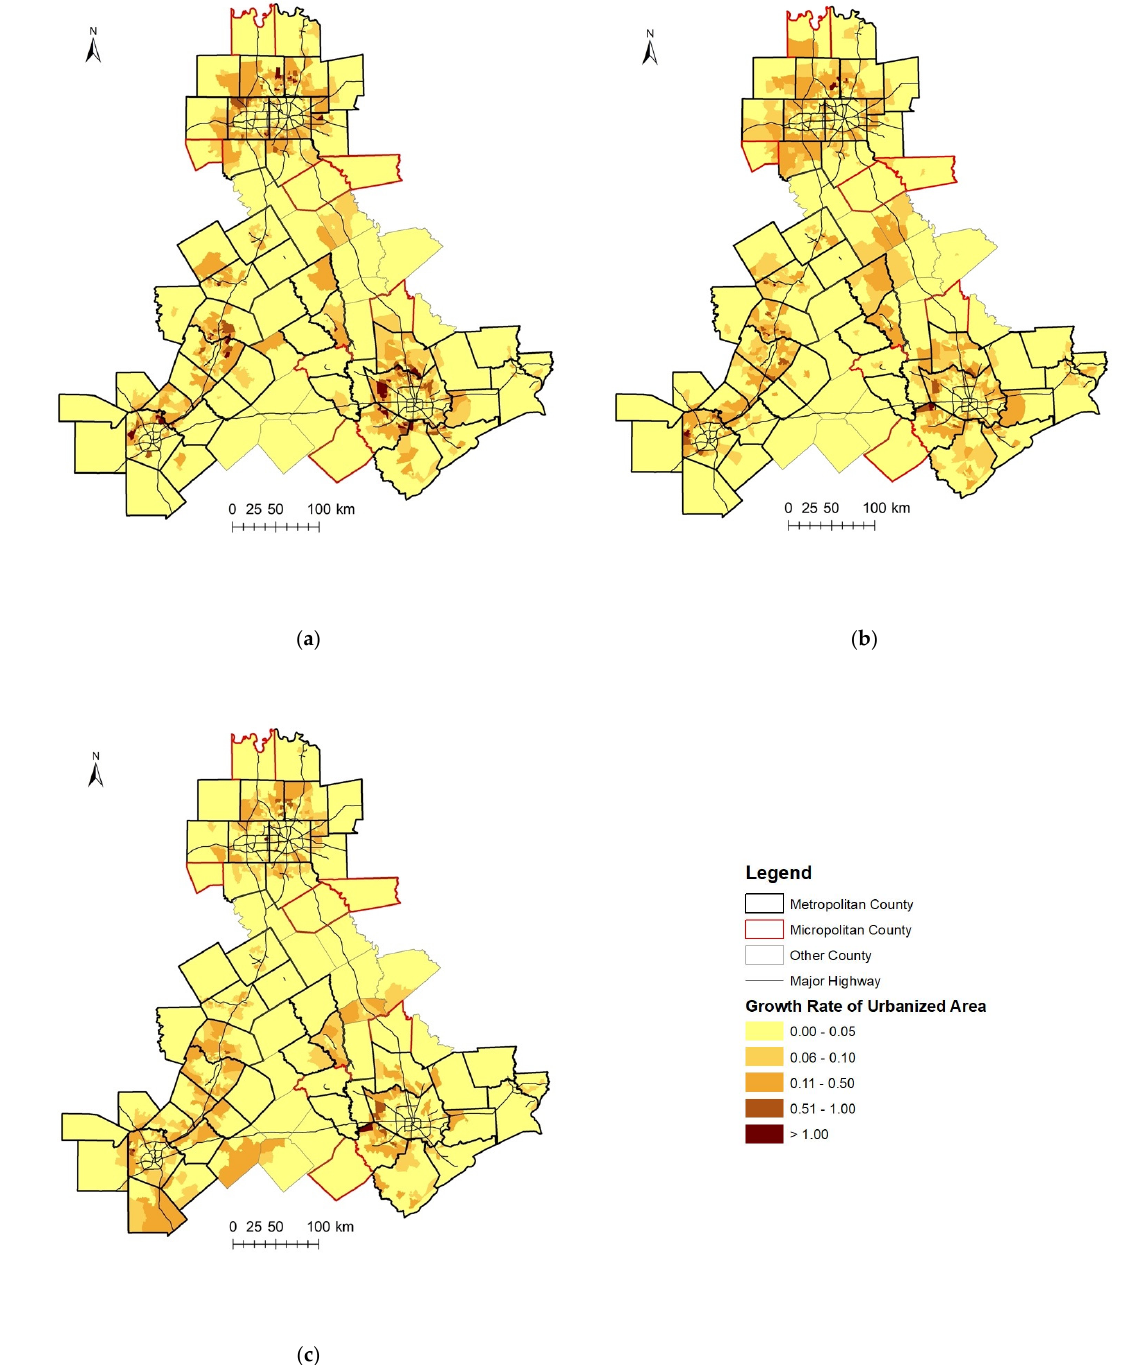
Figure 4. Maps of Urbanized Land Growth Rate in the Texas Triangle from 2001 to 2016: ( a ) 2001–2006; ( b ) 2006–2011; ( c )